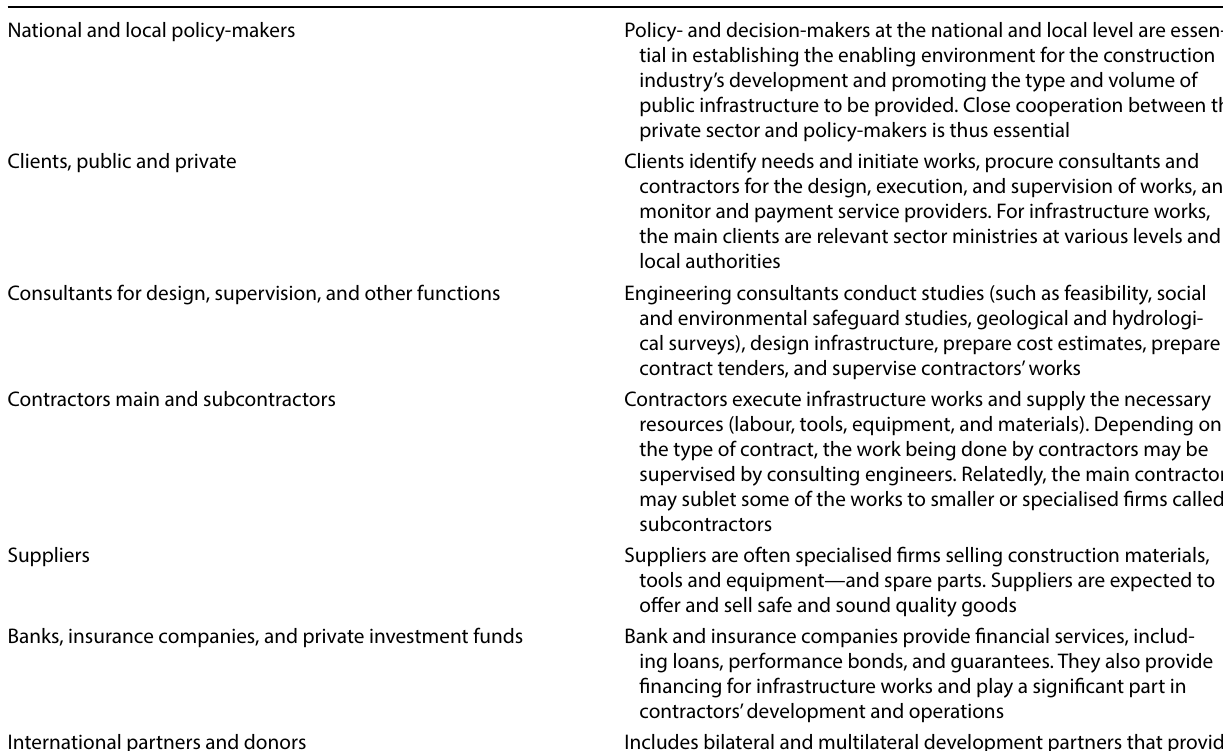
Table 3 Stakeholders (organisations) in the construction industry [48]